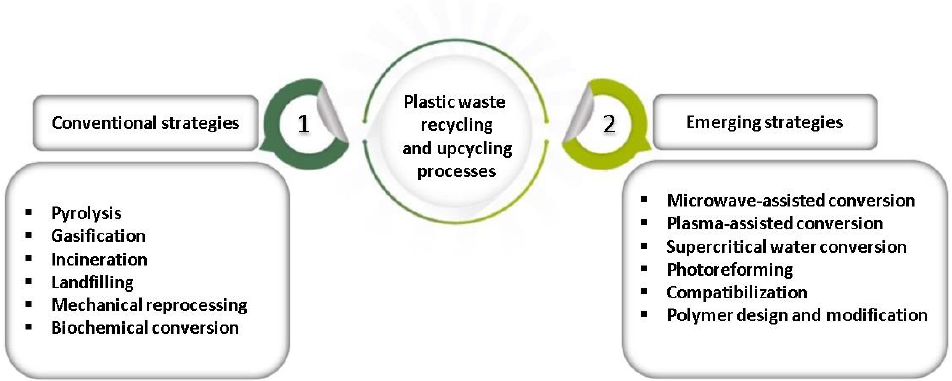
Figure 2. Plastic waste conversion strategies. A comparison of conventional and innovative strate- gies for converting plastic waste. Reprinted with permission from ref. [228]. Copyright 2022 Else- vier.